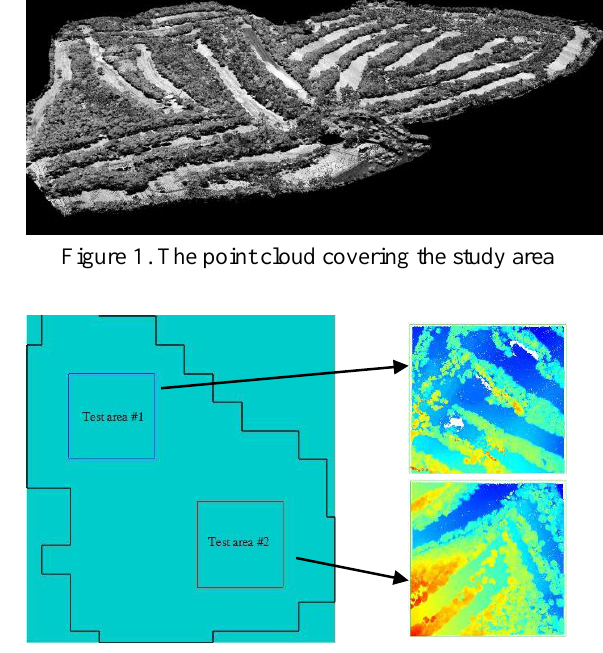
Figure 2. Two test areas in the golf course area bounded by the black